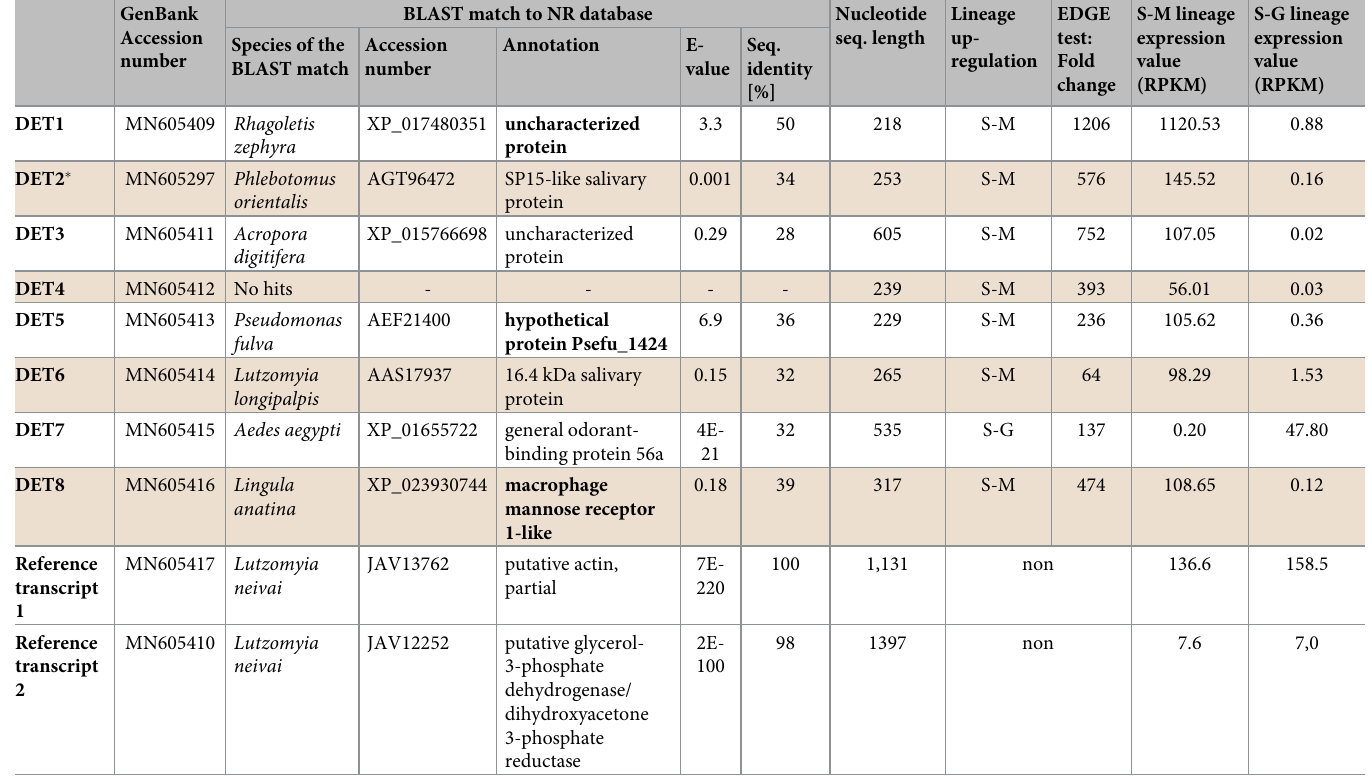
Table 2. Differentially expressed transcripts (DETs)